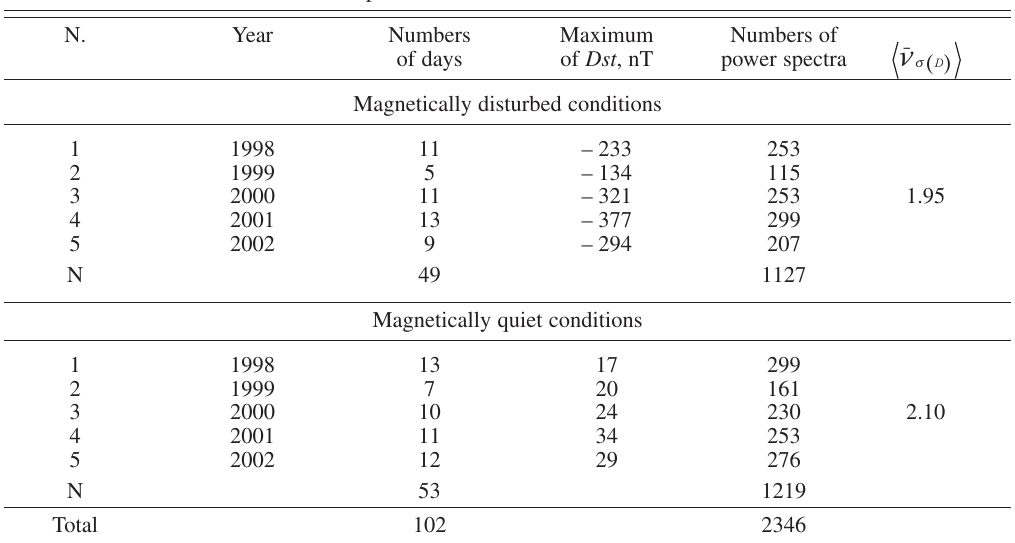
Table I. General information on the experiment.